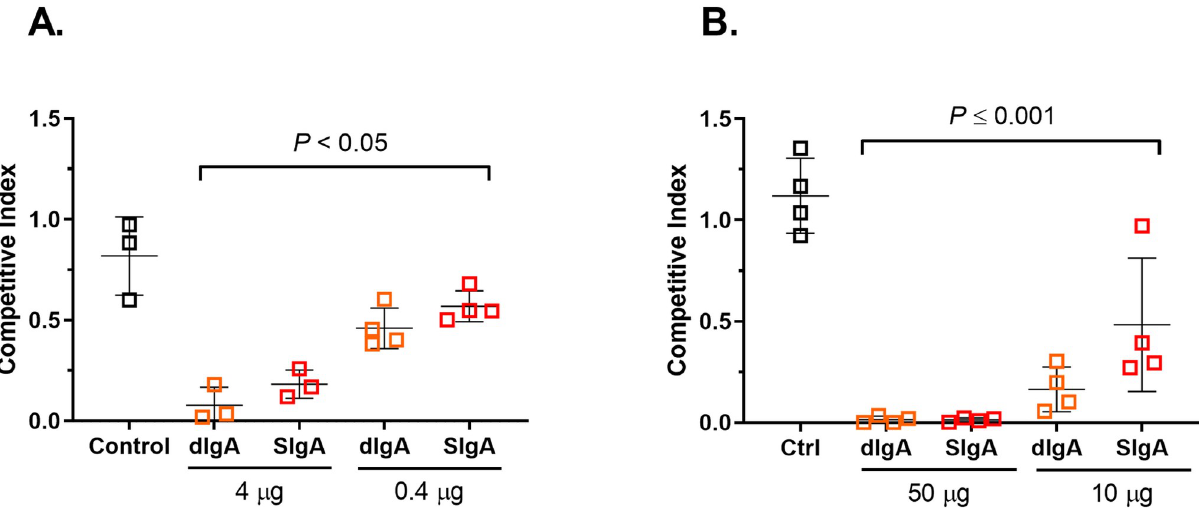
Fig 4. Comparison between Sal4 dimeric IgA (dIgA) and secretory IgA (SIgA) preparations in mouse model of STm infection. Adult BALB/c mice were challenged by gavage with a one-to-one mixture of STm O5 and O4 strains (4 x 10 7 CFU total). Dimeric IgA (dIgA) or secretory IgA (SIgA) forms of Sal4 were (A) premixed with the bacterial inoculum or (B) administered ~1 min prior to STm challenge. The mice were euthanized 24 h later and Peyer’s patches were assessed for bacterial loads. Shown are the results of two independent experiments with 4 mice per group. Statistical significance evaluated for each concentration over the isotype control, as determined by one-way ANOVA and Tukey’s post-hoc